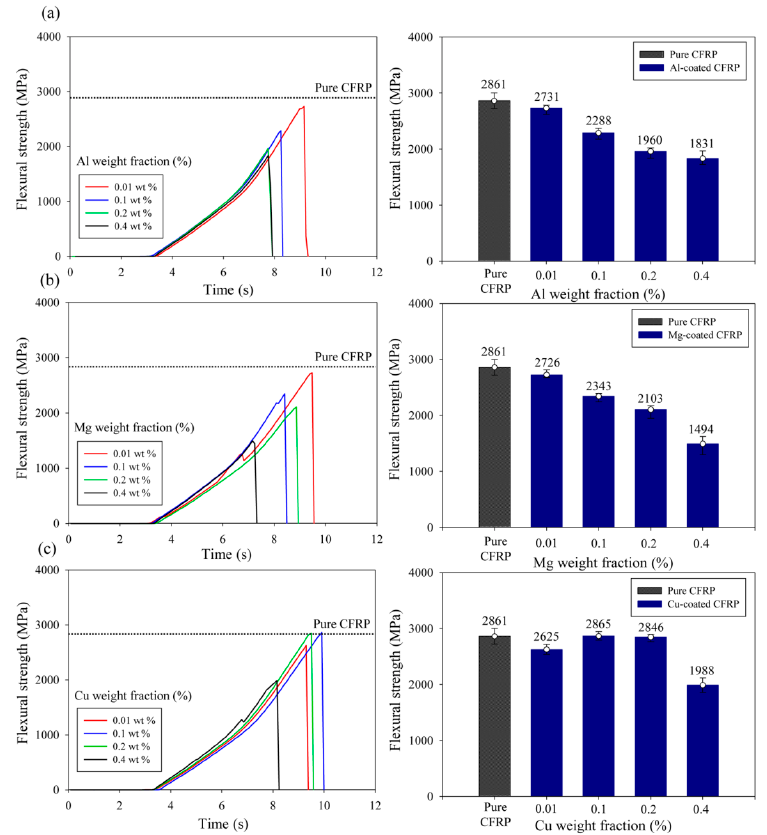
Figure 6. Flexural strength of CFRP composites coated with three types of inorganic crystal fillers: ( a ) aluminum; ( b ) magnesium; ( c ) copper.